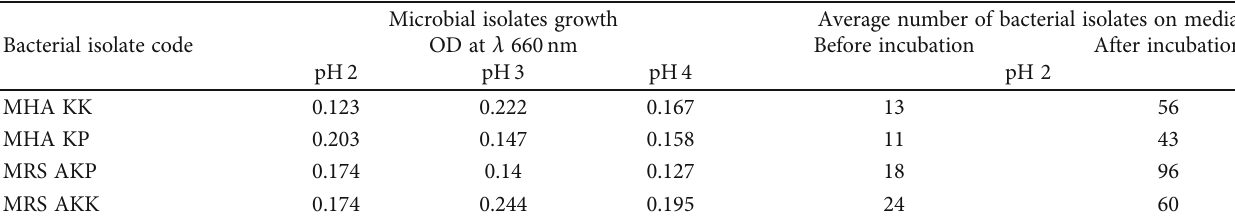
Table 2: Acid tolerance results.